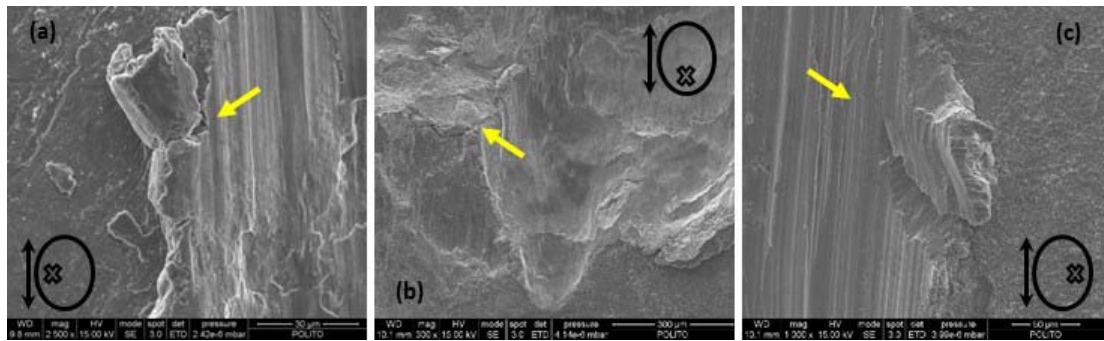
Figure 10. SEM, accumulation and fracture: ( a ) pair 01—flat; ( b ) pair 07—flat; ( c ) pair 07—flat.